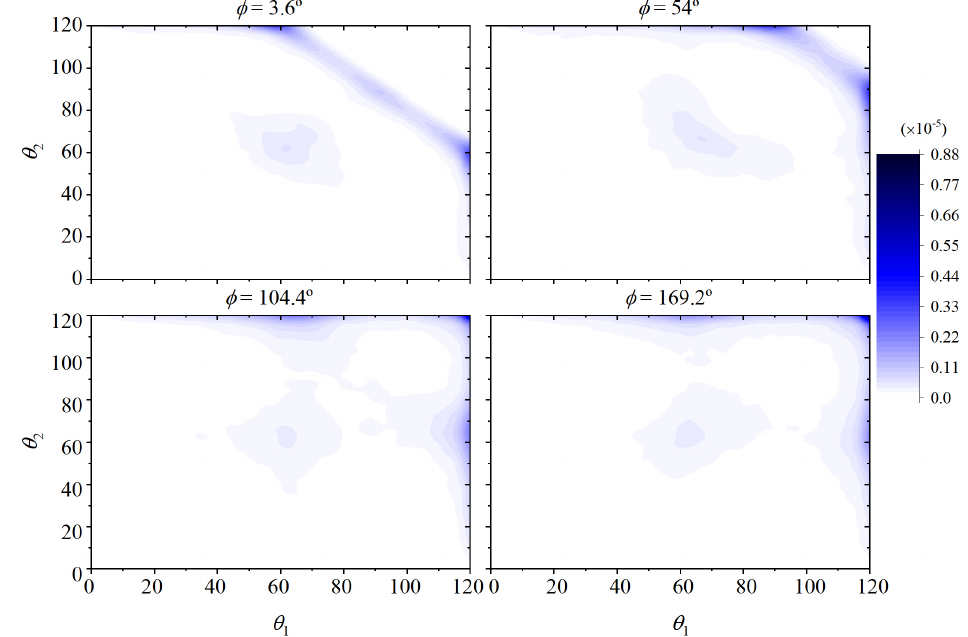
Figure 8. Sections of the joint orientational functions of bending and torsional angles in the initial ( θ ) for four values of the torsion angle φ amorphous state f am 1 , φ , θ 2 bt